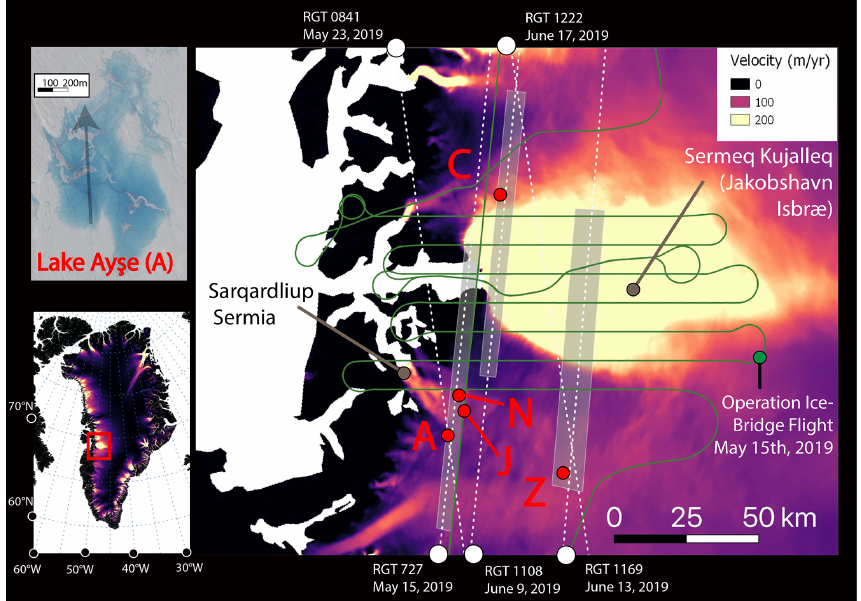
Figure 1. Study region over Sermeq Kujalleq and Sarqardliup Sermia. Top left panel: Lake Ay¸se on 23 May using Planet SkySat Visual imagery. Bottom left panel: study region over western Greenland. Right panel: main region with repeat-tasking locations for Planet SkySat shown in grey boxes over annual velocity estimates from MEaSUREs (NSIDC). ICESat-2 reference ground tracks shown in white. Operation IceBridge flight on 15 May 2019 shown in green. Five lakes indicated in red discussed throughout text include the following: C: Lake Cecily; A: Lake Ay¸se; J: Lake Julian; N: Lake Niels; Z: Lake